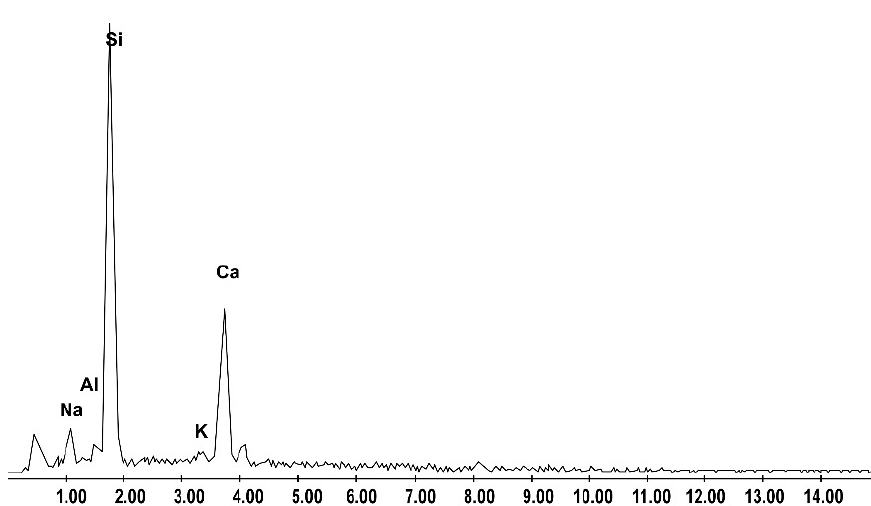
Figure 3. Energy dispersive spectroscopy (EDS) analysis of the glass powder.